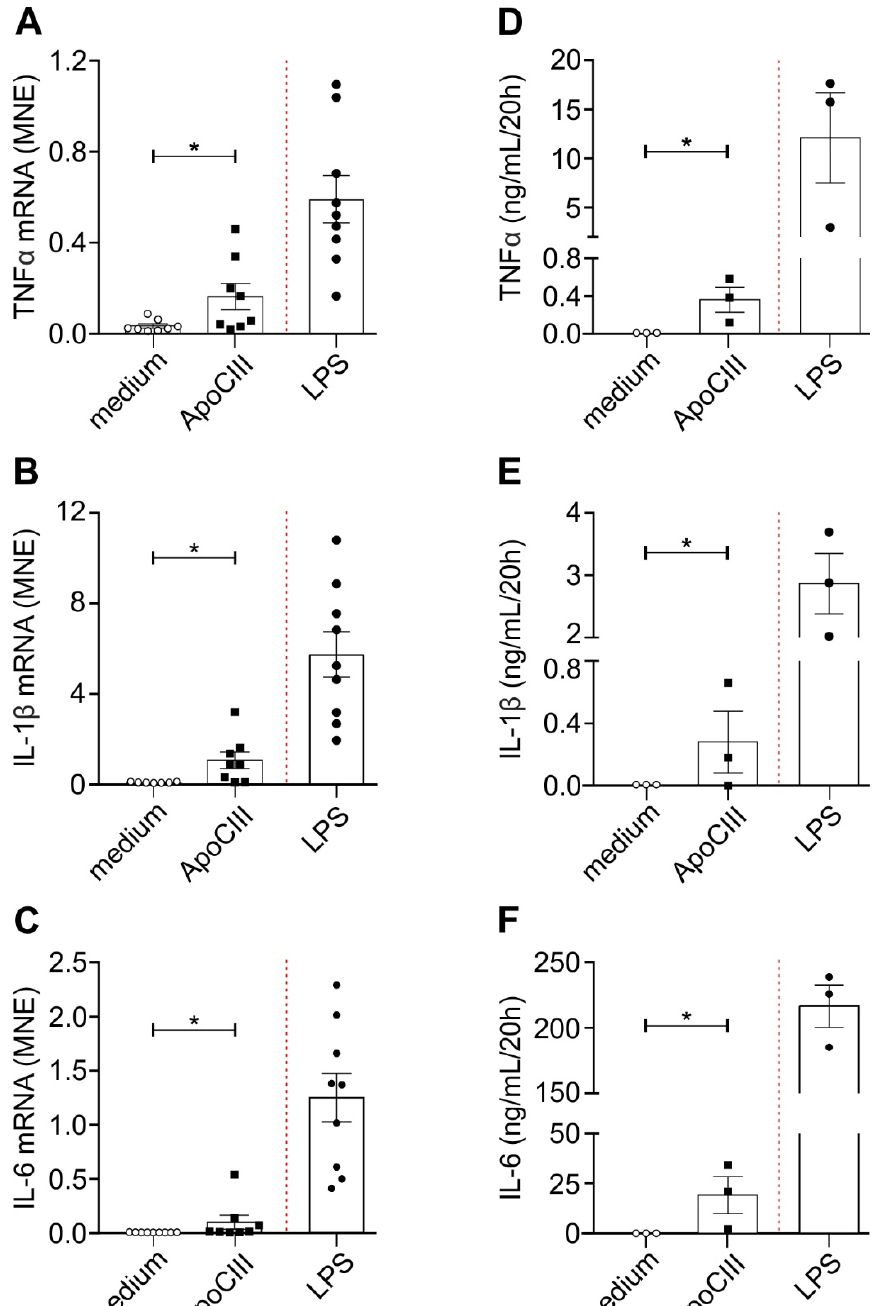
Figure 1. Expression of TNF α , IL-1 β and IL-6 mRNAs and protein release by human CD14 + - monocytes exposed to ApoCIII. Human CD14 + -monocytes, purified as described in Section 4, were incubated for 3 h ( A – C ) or 20 h ( D – F ) in the absence (medium) or presence of 50 µg/mL ultrapure ApoCIII or, as a control, in 100 ng/mL LPS. Total RNA was then extracted and examined for TNF α ( A ), IL-1 β ( B ) and IL-6 ( C ) mRNA expression by RT-qPCR. Gene expression is depicted as mean normalized expression (MNE) units after normalization to GAPDH mRNA (mean ± SEM, n = 7–9). Monocyte-derived supernatants were collected, and TNF α ( D ), IL-1 β ( E ) and IL-6 ( F ) levels were measured by ELISA. Results are expressed as the mean value ± SEM of 3 independent experiments. Statistical analysis by unpaired t-test with Welch correction refers to ApoCIII-treated versus untreated monocytes, * p < 0.05.